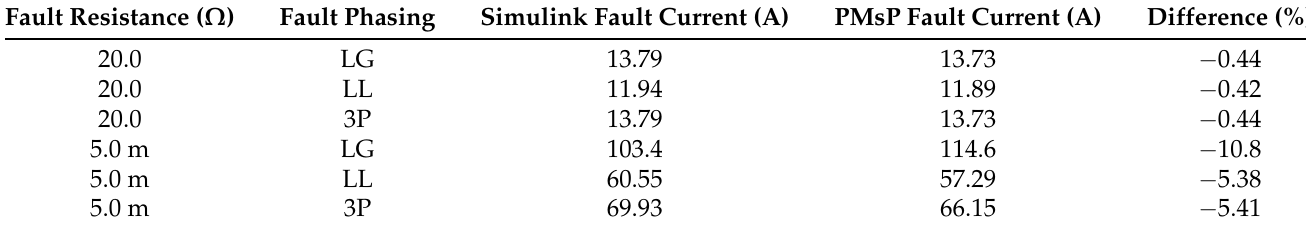
Table 9. Comparison of results for a grid-forming inverter on the microgrid of Figure